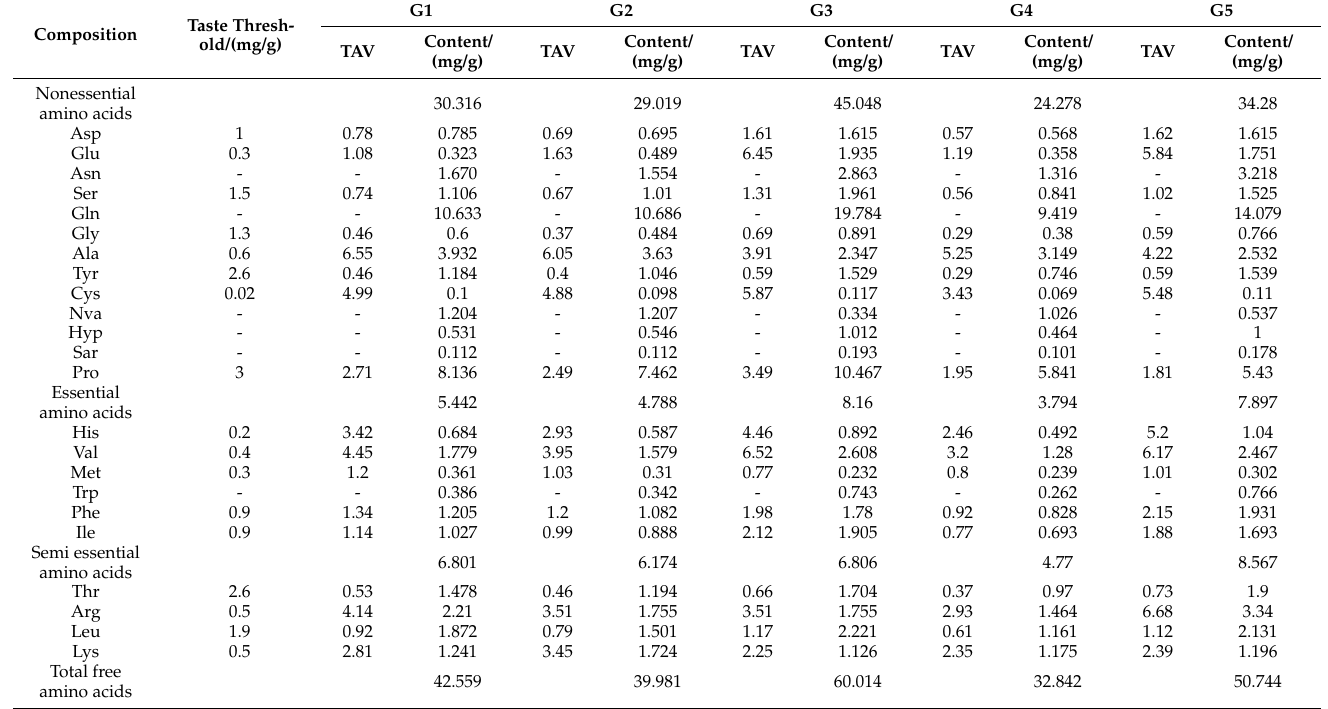
Table 2. FAA content and TAV in pickled BLS with different salt